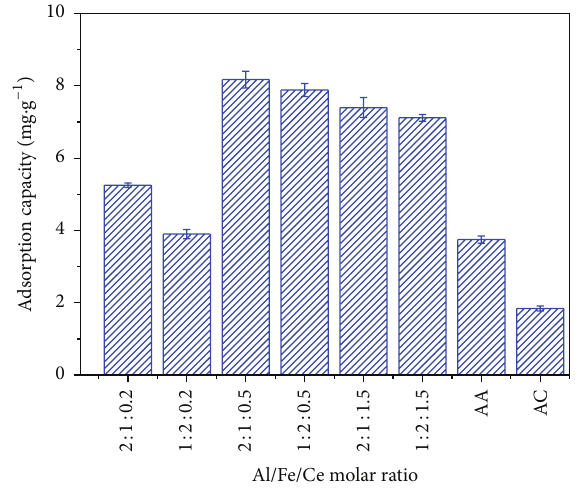
Figure 2: As (III) adsorption capacity onto Ce-Al-Fe trimetal oxide adsorbents with different Al/Fe/Ce molar ratio (pH = 7.0, initial concentration of As (III) = 20 mg ⋅ L −1 , the temperature = 25 ± 1 ∘ C, and adsorbent dosage = 2 g ⋅ L −1